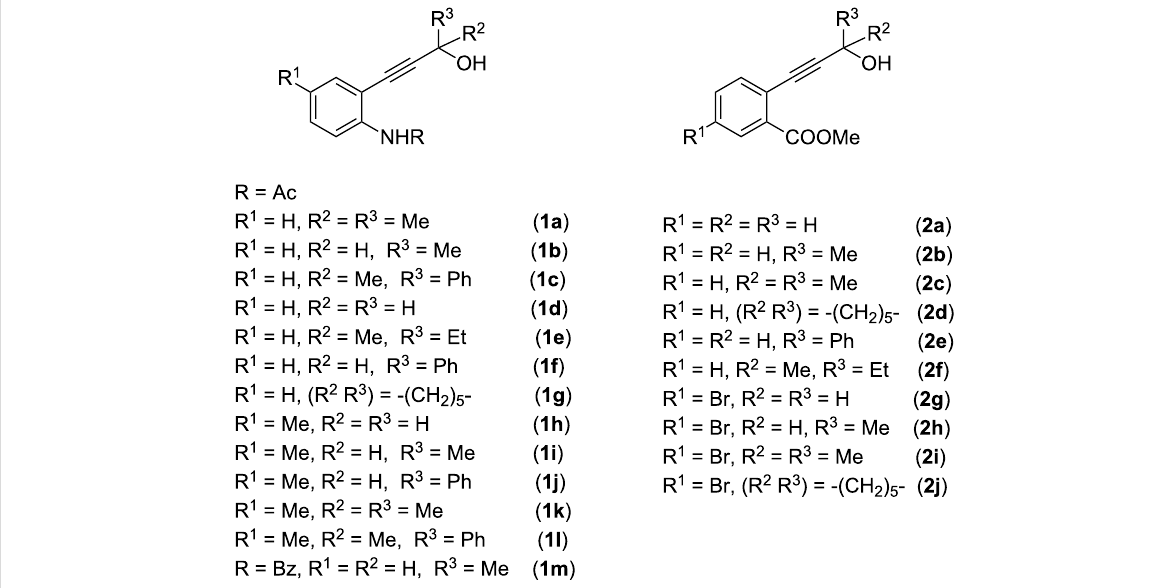
Figure 1: Functionalized propargyl alcohols 1a–m and 2a–j used in the present study.